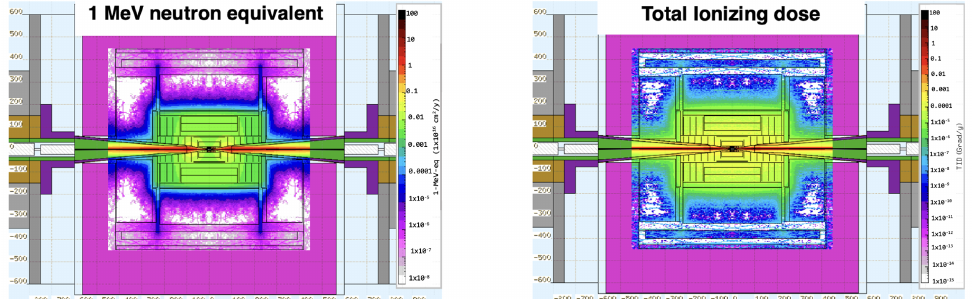
Figure 4. ( Left ): Map of the 1-MeV-neq fluence in the detector region for a Muon Collider operating √ s = 1.5 TeV with the parameters described in [3], shown as a function of the position along the at beam axis and the radius. ( Right ): Map of the TID in the detector region shown as a function of the position along the beam axis and the radius.